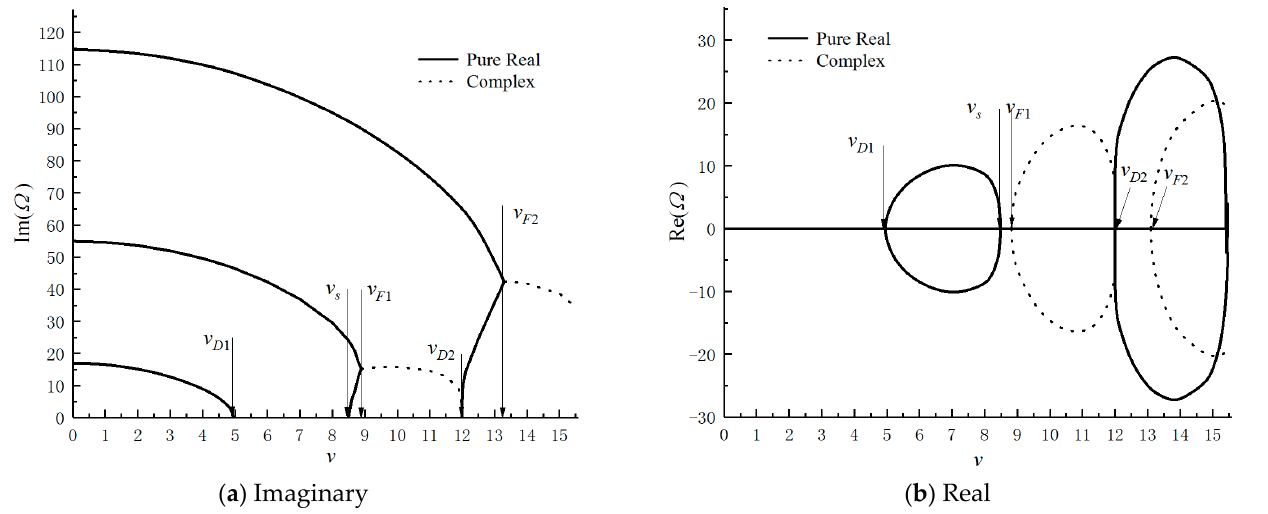
Figure 4. Curve of the imaginary part of the first three complex frequencies of CS beam changing with axial velocity.